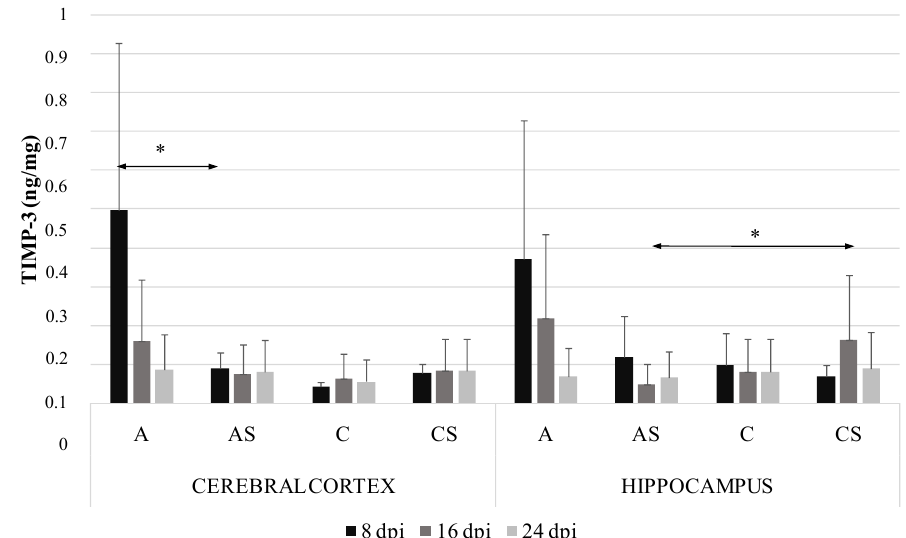
Figure 4. Tissue inhibitors of metalloproteinase-3 (TIMP-3) level (ng/mg) in the cerebral cortex and hippocampus in control and infected groups at 8, 16 and 24 days post Acanthamoeba spp. infection (dpi). Data represent means ± SD for 6 independent experiments. C, immunocompetent uninfected control group mice; CS, immunosuppressed uninfected control group mice; A, immunocompetent Acanthamoeba spp. infected mice; AS, immunosuppressed Acanthamoeba spp. infected mice; * p ≤ 0.05 for the significance of difference (Mann–Whitney U test).